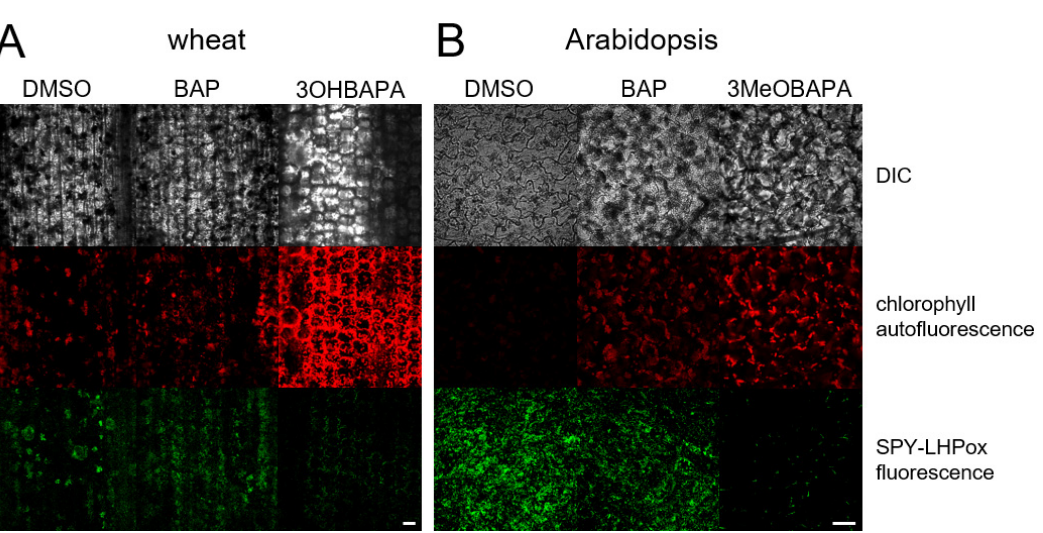
Figure 8. In vivo imaging of lipid hydroperoxides (LOOHs) using fluorescent probe SPY-LHP in ( A ) wheat and ( B ) Arabidopsis leaves kept in the dark for 6 days and subsequently exposed to high light (500 µmol photons·m − 2 ·s − 1 ) for 4 h. Detached leaves were incubated in 0.1% DMSO or 10-µmol·L − 1 solutions of BAP, 3OHBAPA or 3MeOBAPA. Scale bars represent 50 µm. DIC, differential interference contrast.